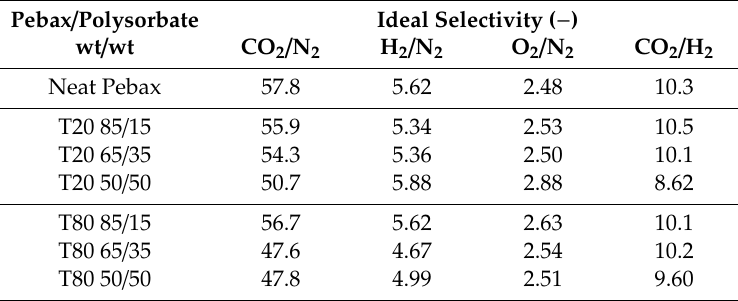
Table 4. Ideal selectivity of Pebax ® 1657 and Pebax ® 1657 + T20 or T80 blend membranes. Pebax /